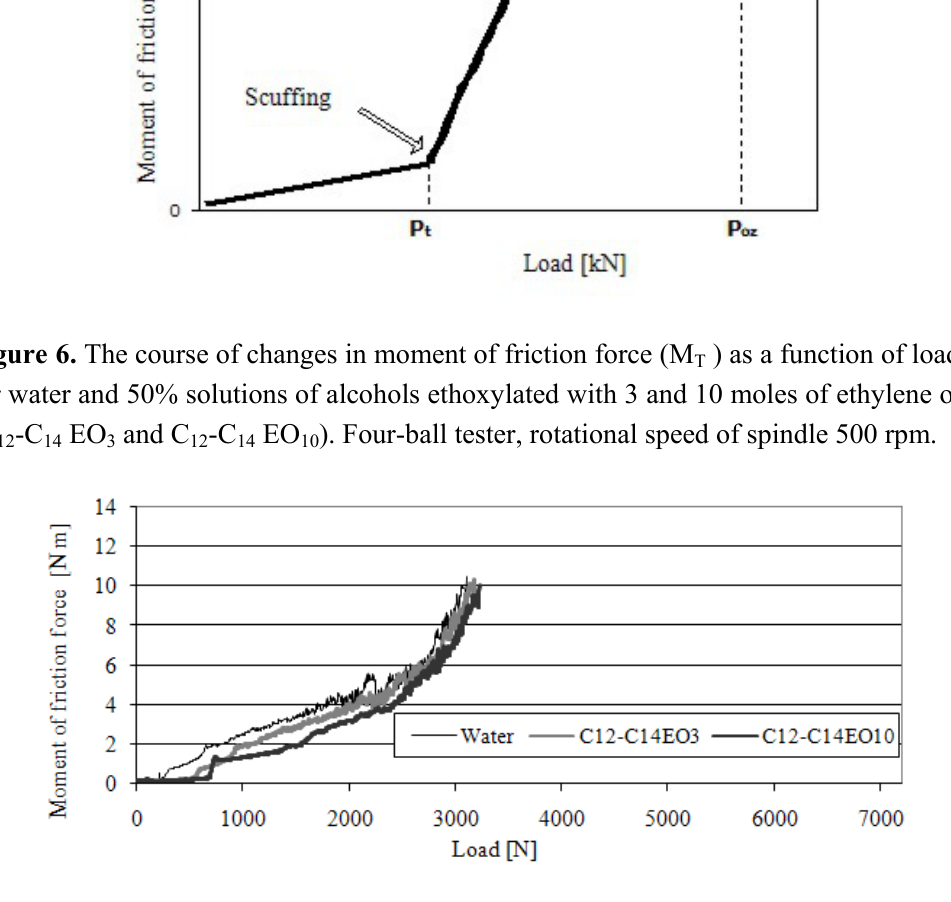
Figure 5. Model dependence of moment of friction force (M load (P) increase.